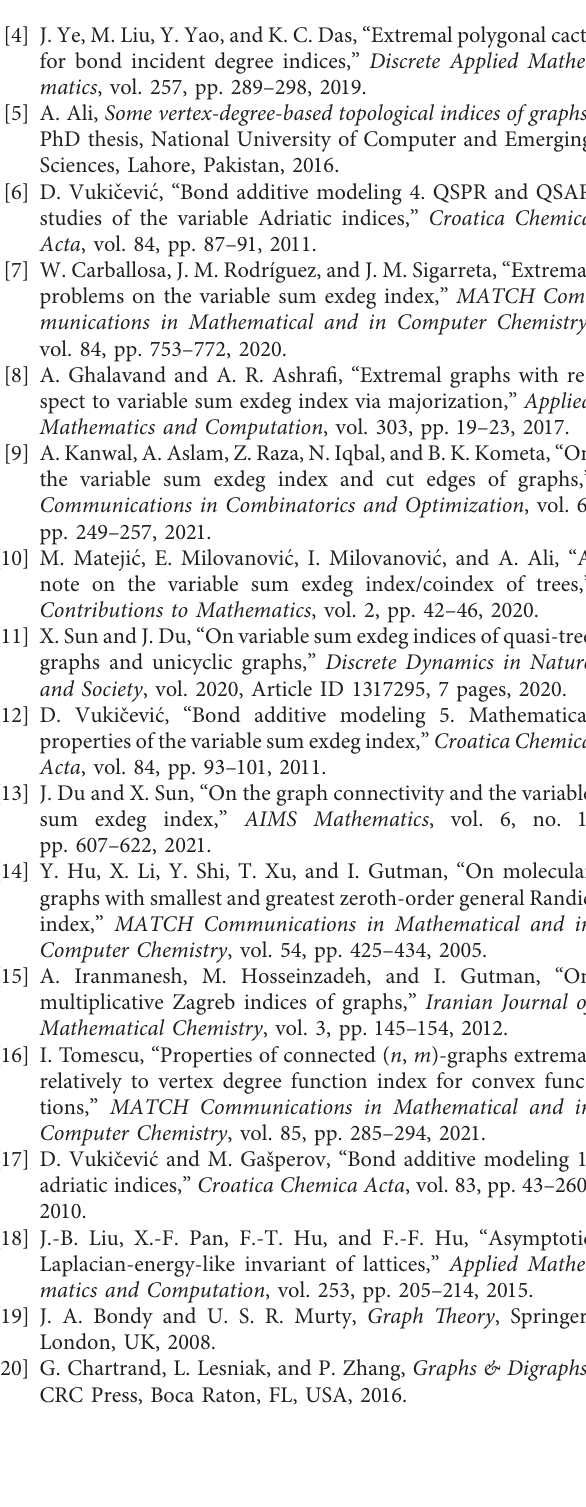
Figure 1: The graph C